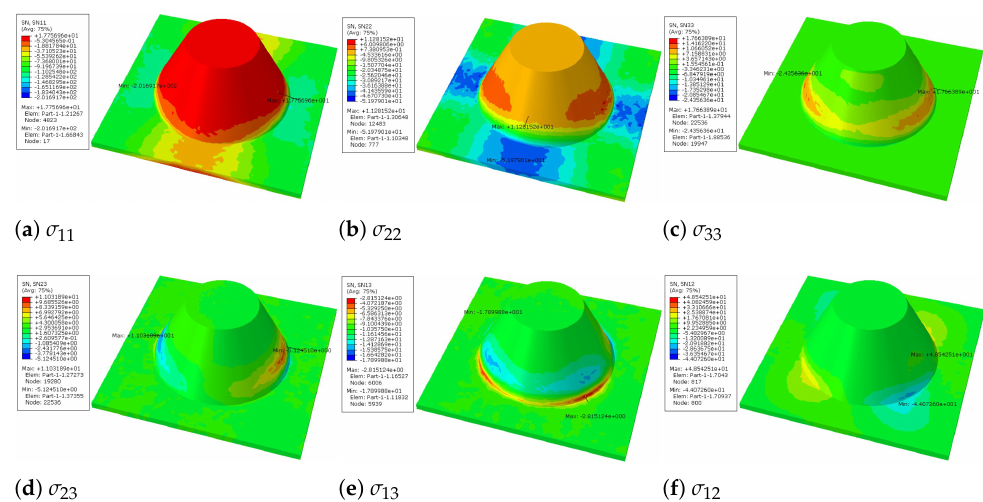
Figure 6. Local stress distributions within the unit cell closest to the center of the plate in Case 1.